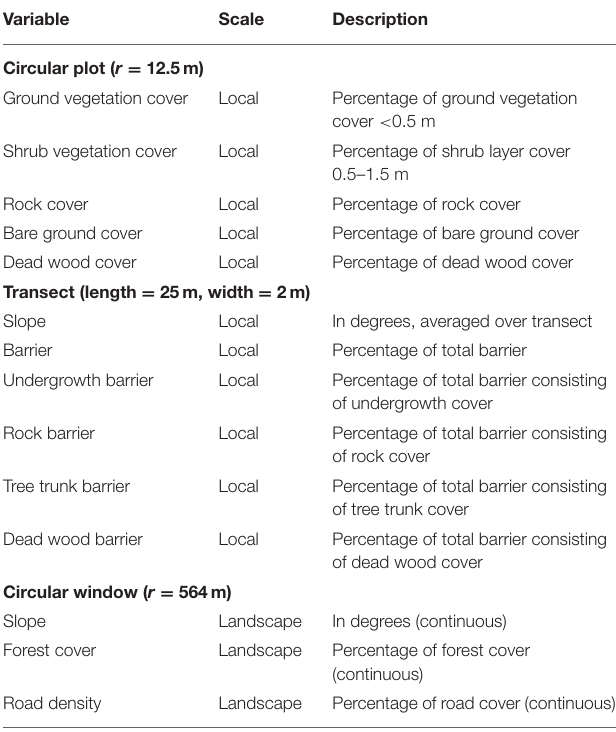
TABLE 1 | Variables describing the surroundings of the camera-trap sites, obtained from field mapping (local scale) or extant databases (landscape scale). Variable Scale Circular plot ( r =